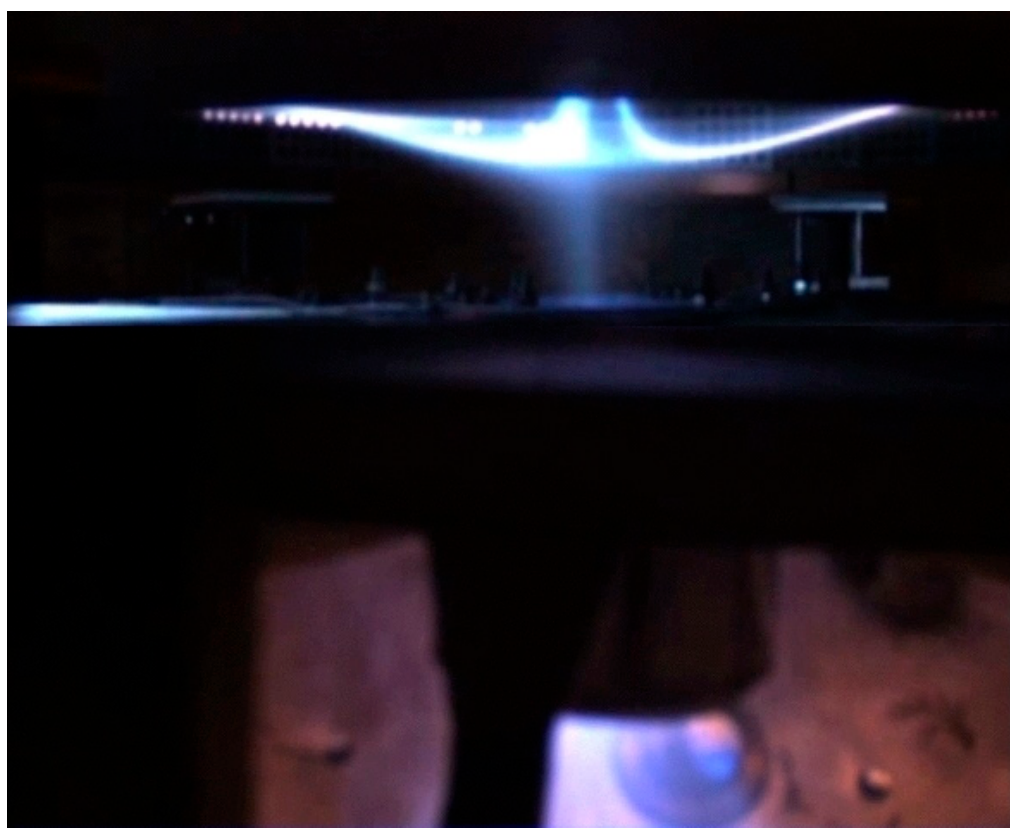
Figure 20. Triple X ‐ point observed above the anode, as expected from calculations [25]. Figure 20. Triple X-point observed above the anode, as expected from calculations